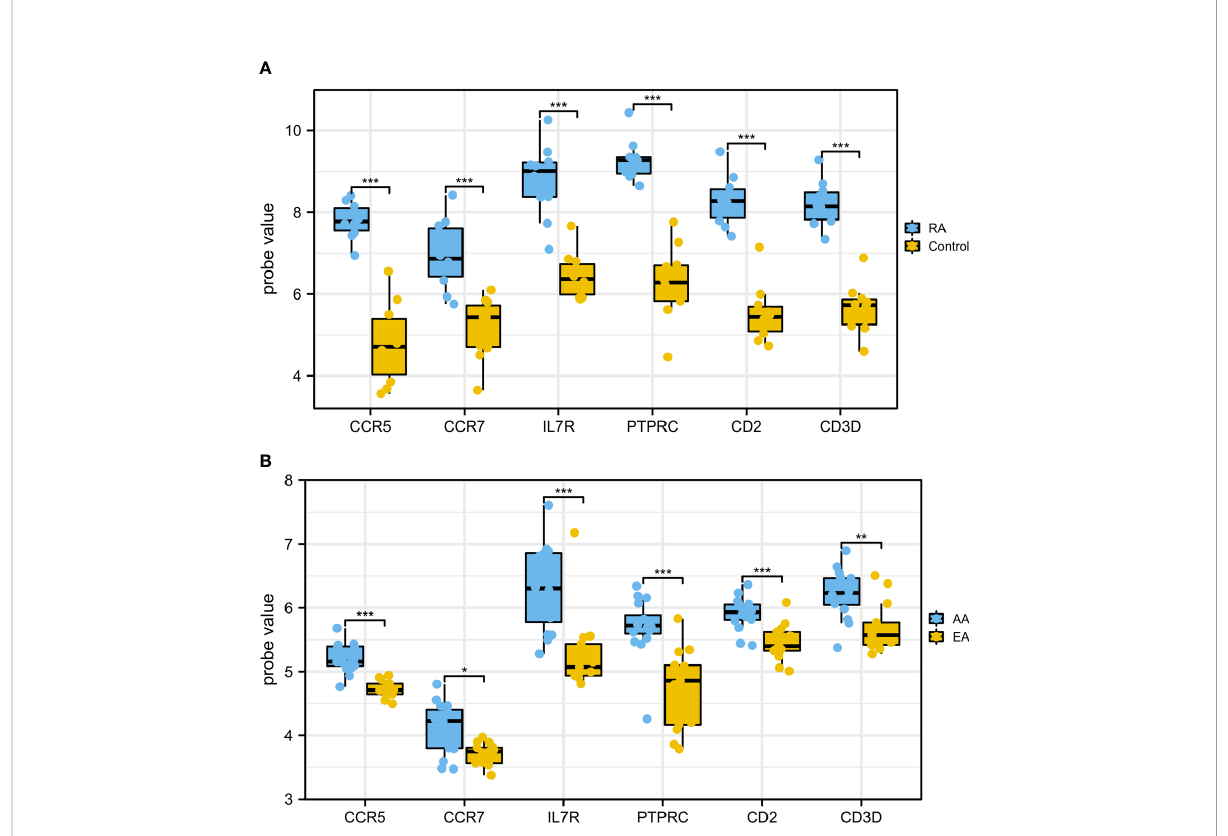
FIGURE 8 The expression of hub genes in (A) GSE55235 and (B) GSE28829. The comparison between the two datasets used the mean t-test. P < 0.05 was considered to be statistically signi fi cant. EA, early atherosclerotic plaques; AA, advanced atherosclerotic plaques. *P < 0.05; **P < 0.01; ***P <